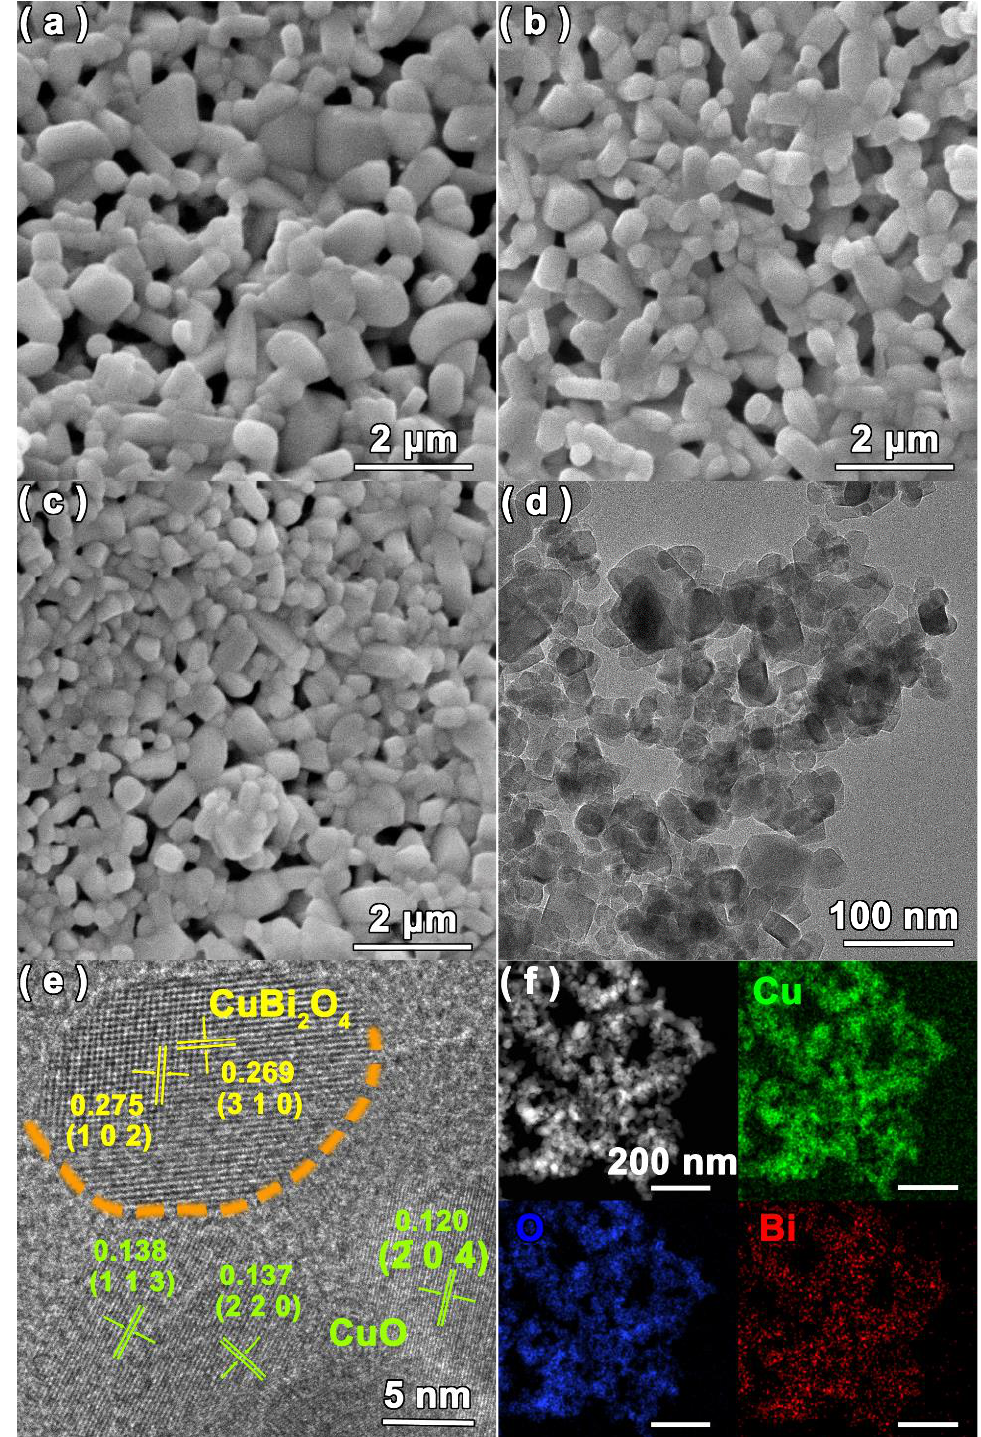
Figure 2. SEM images of ( a ) CuBi 2 O 4 , ( b ) CuO and ( c ) 30CBO/CuO samples; ( d ) TEM image, ( e ) HRTEM image and ( f ) EDX mapping images of the 30CBO/CuO sample.